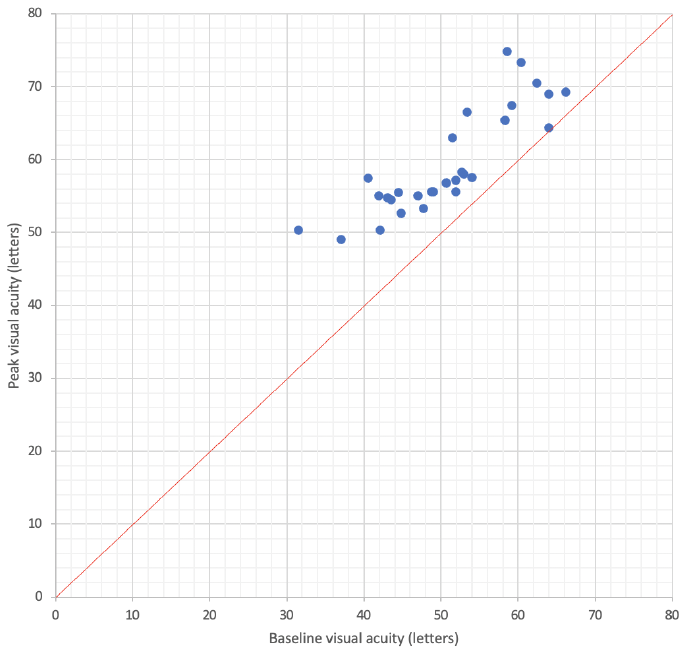
Figure 2. Peak visual acuity as a function of baseline visual acuity in real-world studies evaluating the efficacy of the fluocinolone acetonide implant for diabetic macular edema. Mean follow-up was 20.0 months ( n = 22 studies).